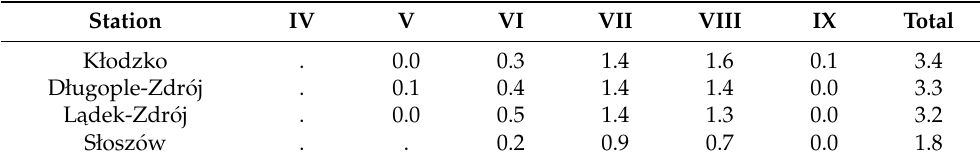
Table 4. Mean frequency of heat days (T max > 30 ◦ C) in the warm half-year in Kłodzko Land in